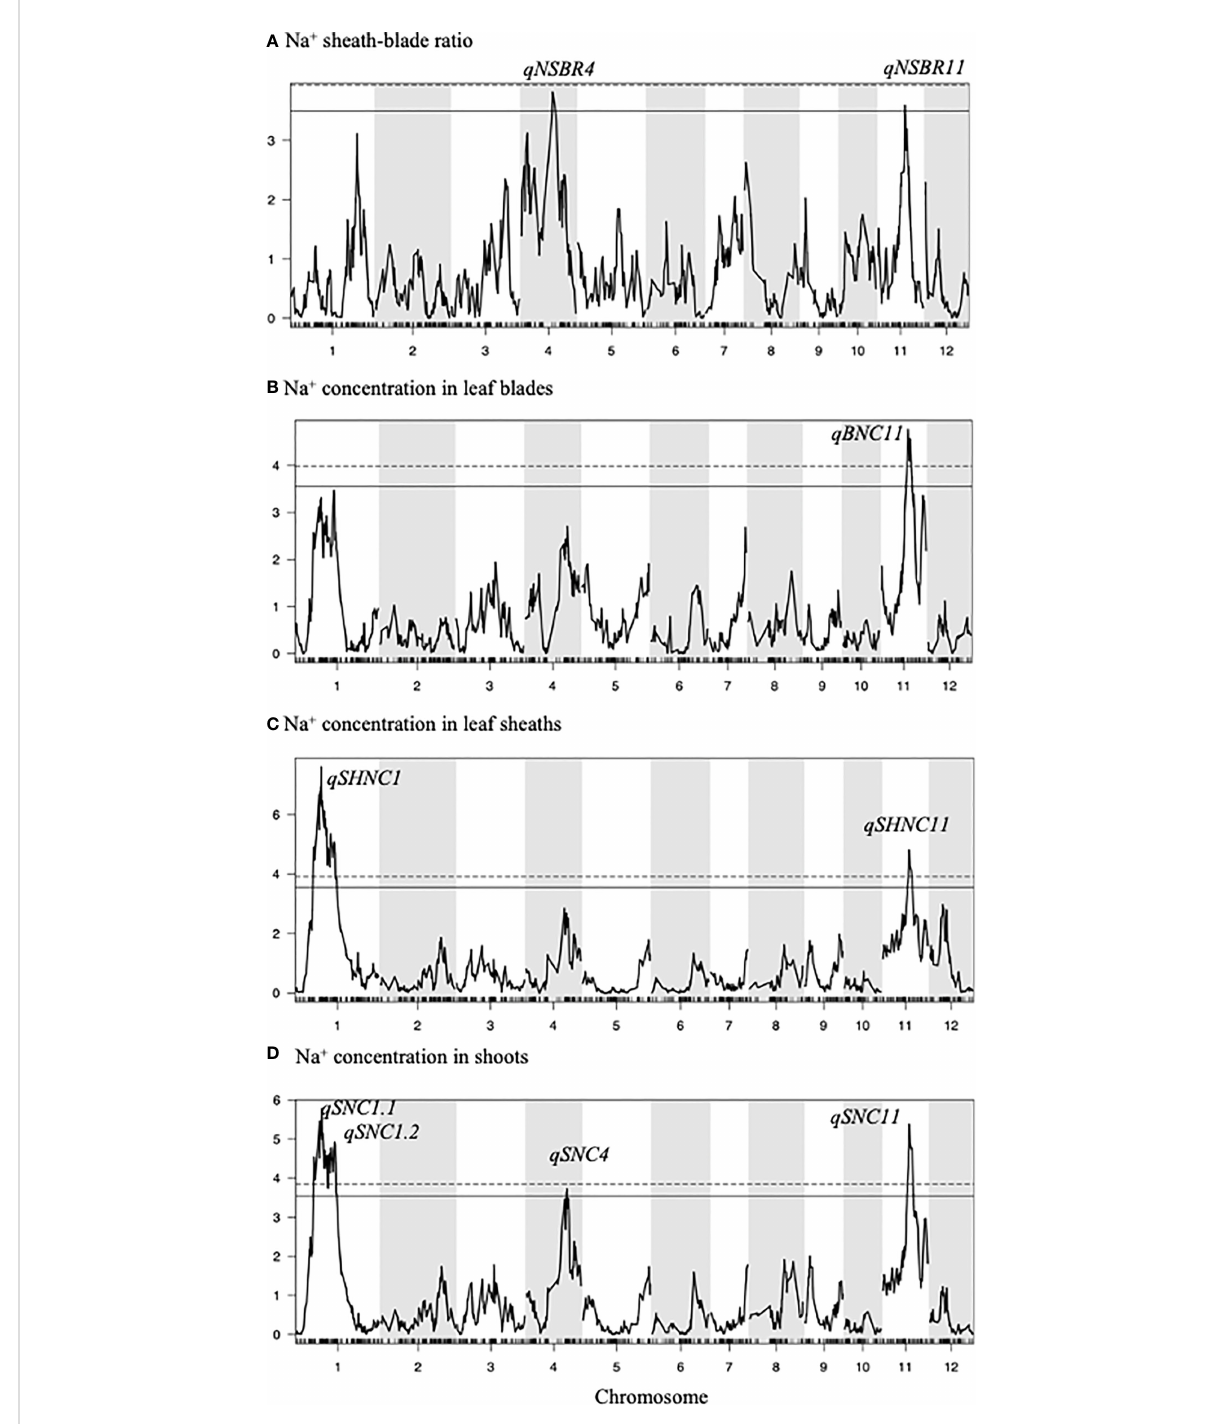
FIGURE 2 Interval mapping showing the QTLs. Trait is shown on each plot. Horizontal dotted and solid lines in all plots indicate am empirical threshold at the 5% and 10% level, respectively. For Na + sheath-blade ratio, no signi fi cant QTL was detected but qNaSBR4 (LOD = 3.81) and qNaSBR11 (LOD = 3.59) were shown as a suggestive QTL (over the empirical threshold at the 10%